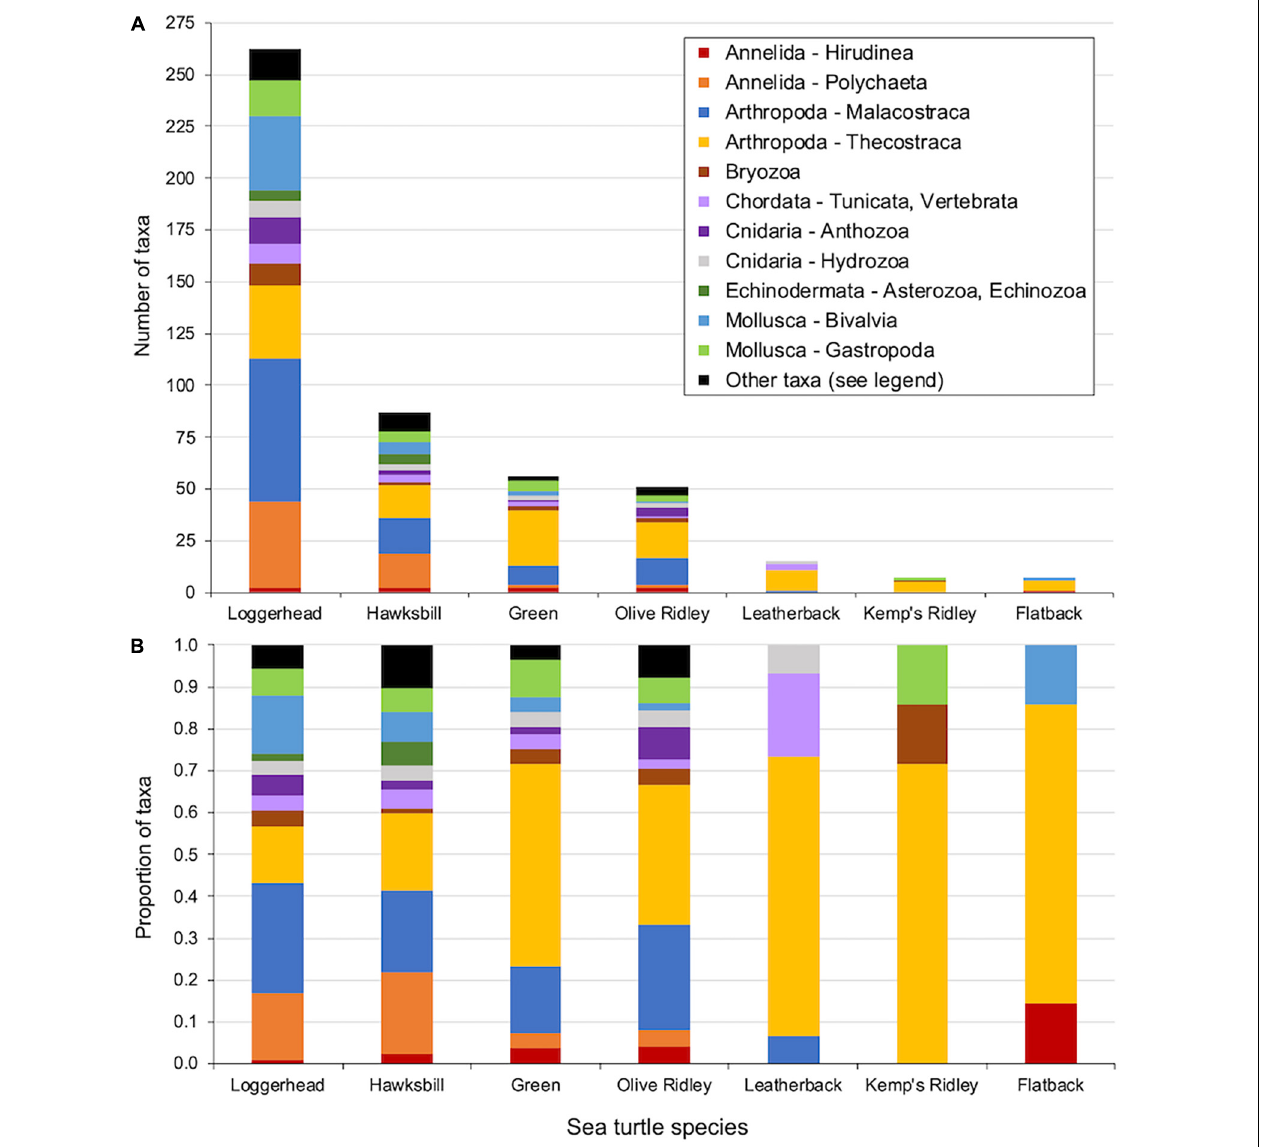
FIGURE 2 | Taxonomic composition of the epibiont communities reported from all seven sea turtle species. (A) Number of taxa per Higher Taxon category (either full Phylum or select phyla differentiated by Subphylum/Class/Subclass) and (B) proportion of taxa per Higher Taxon category. The category “Other taxa” combines taxa from 10 Higher Taxon categories in which fewer than six total taxa were documented across all turtle species (Loggerhead: Annelida – Oligochaeta, Arthropoda – Ostracoda, Arthropoda – Pycnogonida, Mollusca – Polyplacophora, Nemertea, Platyhelminthes, Porifera, and Sipuncula; Hawksbill: Annelida – Oligochaeta, Arthropoda – Insecta, Arthropoda – Ostracoda, Mollusca – Polyplacophora, Platyhelminthes, Porifera, and Sipuncula; Green: Arthropoda – Arachnida and Platyhelminthes; Olive Ridley: Arthropoda – Pycnogonida, Mollusca – Polyplacophora, Platyhelminthes, and Porifera). See Supplementary Table 1 for numerical summary of the number of epibiont taxa reported within each Higher Taxon for each sea turtle